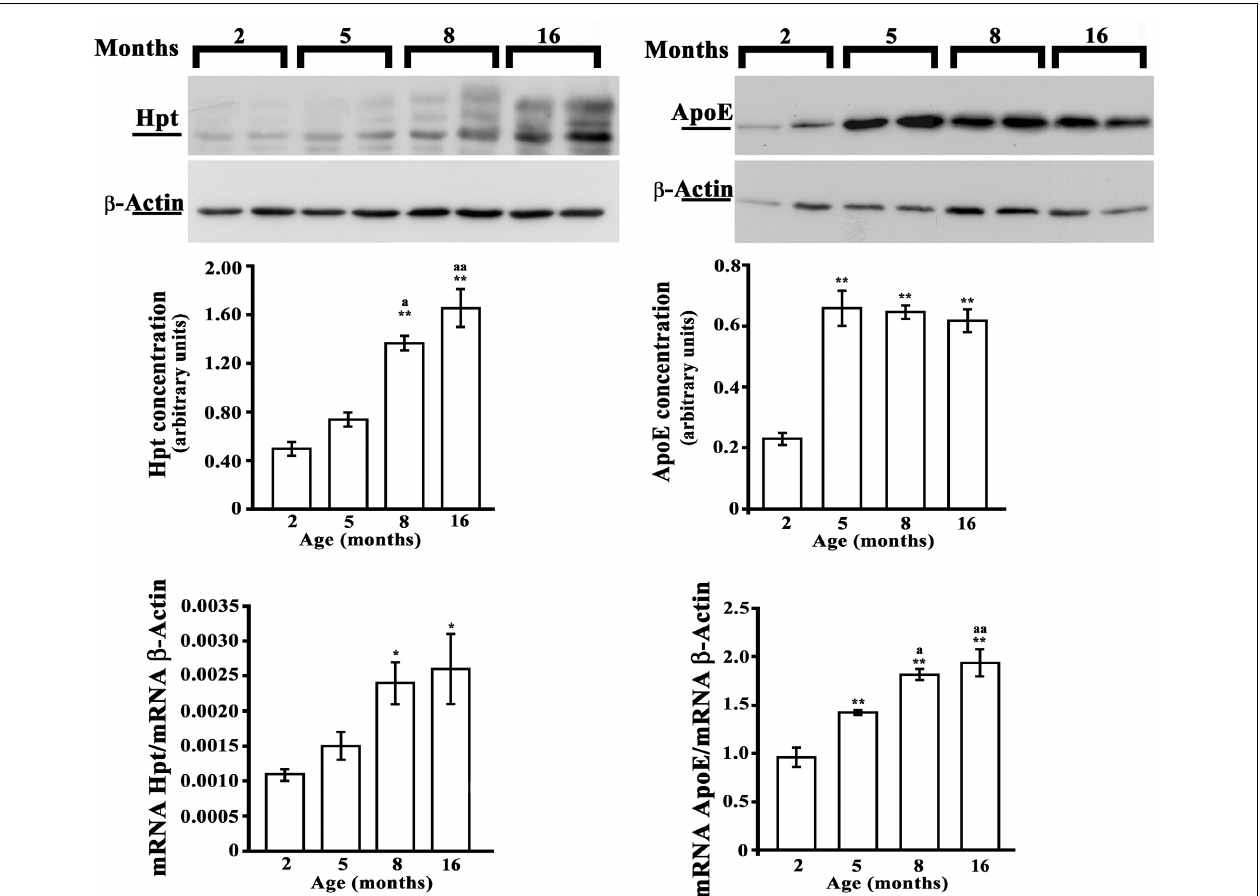
FIGURE 6 | Hpt and ApoE expression in rat hippocampus. Hpt (left side) and ApoE (right side) protein and mRNA levels in hippocampus of 2, 5, 8, and 16 month-old rats are shown. Representative Western blots stained with anti-Hpt (left) or anti-ApoE (right) IgG, and anti-actin IgG are shown. Samples were analyzed by 12.5% SDS-PAGE and western blotting. Immunocomplexes were detected by rabbit anti-Hpt and GAR-HRP IgGs (on the left) or by goat anti-ApoE and RAG-HRP IgGs (on the right). After Hpt or ApoE detection, the